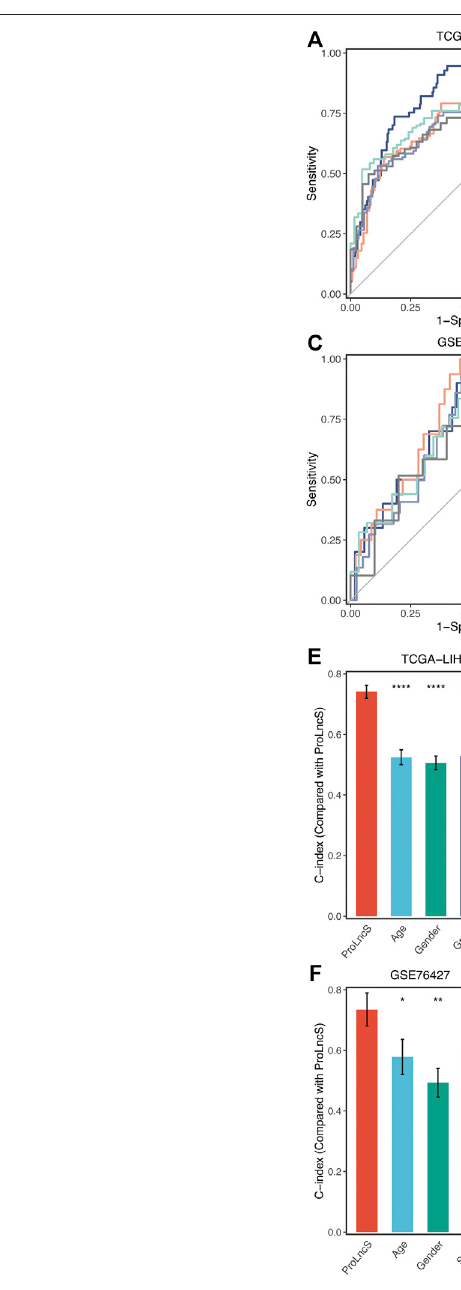
Frontiers in Pharmacology |